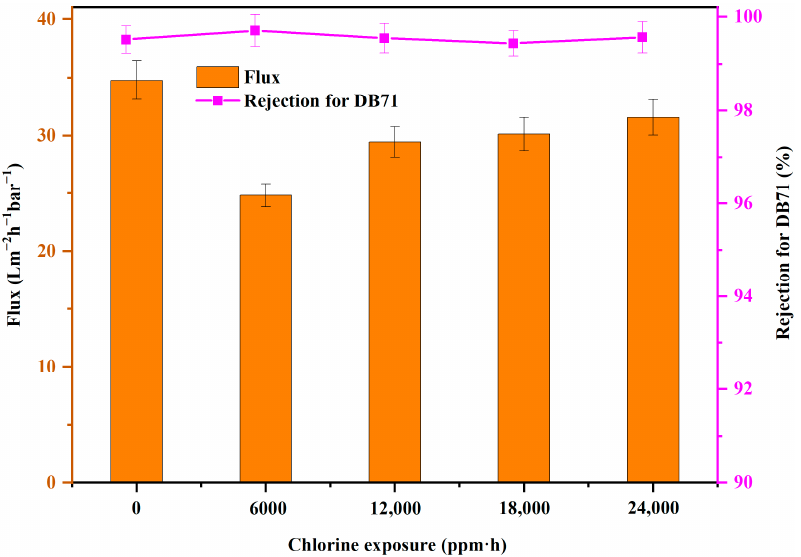
Figure 16. The dye rejection and water flux of PES–DPS–1 with different chlorine expose amount. Furthermore, the FTIR analysis of PES–DPS–1 after its immersion in chlorine was performed to determine the stability of the PA layer. As shown in Figure 17, the absorption peaks at 1631 cm − 1 , 1518 cm − 1 , and 1446 cm − 1 corresponding to the amide bond of the PA layer on the PES–DPS–1 membrane surface were still present after the membrane immer- sion in chlorine. The N 1s and O 1s high-resolution spectra of PES–DPS–1 (Figure 18) barely changed after membrane immersion in chlorine. These results indicate the maintained stability of the amide-rejection layer. The excellent chlorine resistance by the PES–DPS–1 membrane could be explained by the strong electron-withdrawing effect of the O=S=O groups of DPS. The introduction of O=S=O groups as the protective groups can signi fi cantly reduce the density of electron clouds and make the aromatic ring less reactive, thus inhibiting the conversion of N–H groups into N–Cl and Orton rearrangement [43,44].